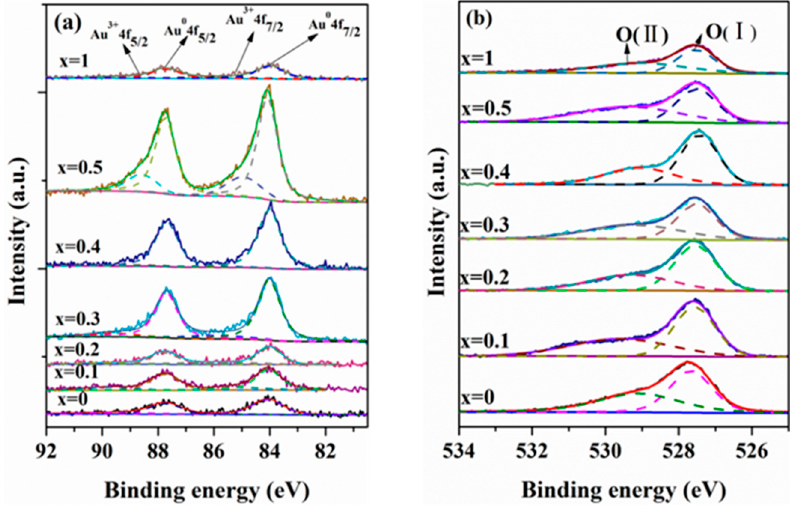
Figure 5. XP spectra of the ( a ) Au(4f) and ( b ) O(1s) of 0.6 wt % Au supported on Ce x Zr 1 − x O 2 .